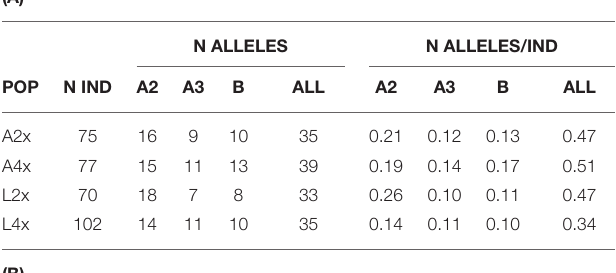
TABLE 4 | Proportion of individuals that tested positive for SRK 01 specificity using direct Sanger and 454 sequencing, indicating the population (A2x = diploid A. arenosa ; A4x = tetraploid A. arenosa ; L2x = diploid A. lyrata ; L4x = tetraploid A. lyrata ), sample sizes (N-direct, N-454) and % of individuals that tested positive for SRK 01 in